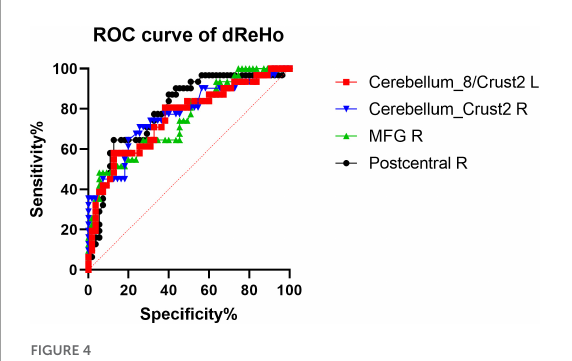
FIGURE4 Receiver operating characteristic (ROC) curve analysis of the mean dReHo values for altered brain regions. The AUCs for dReHo values were as follows: cerebellum_8/crust2_L, 0.76; cerebellum_crust2_R, 0.77; MFG_R, 0.75; post-central gyrus, R, 0.80. MFG_R: right middle frontal gyrus; AUC: area under the curve.